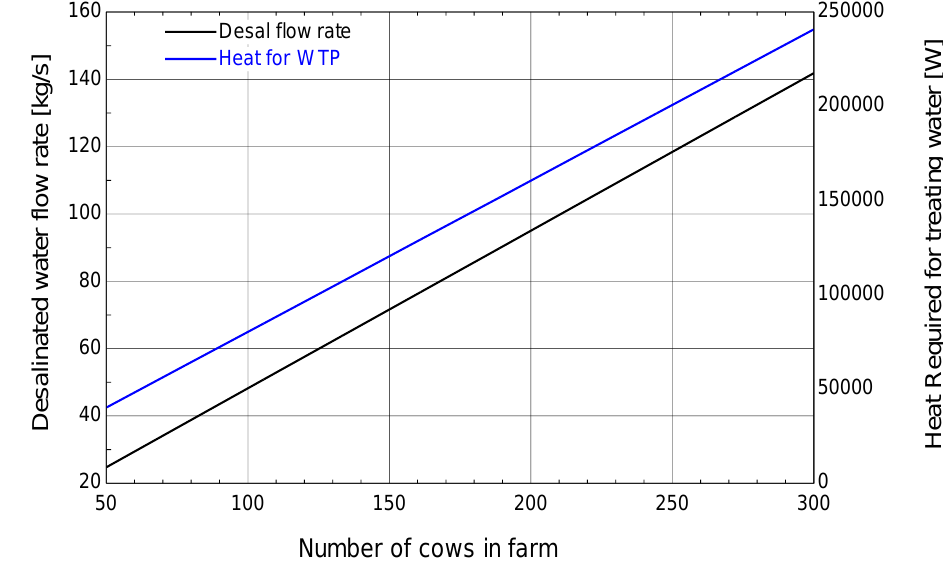
Figure 15. Effect of number of cows on a farm on desalinated water flow rate.